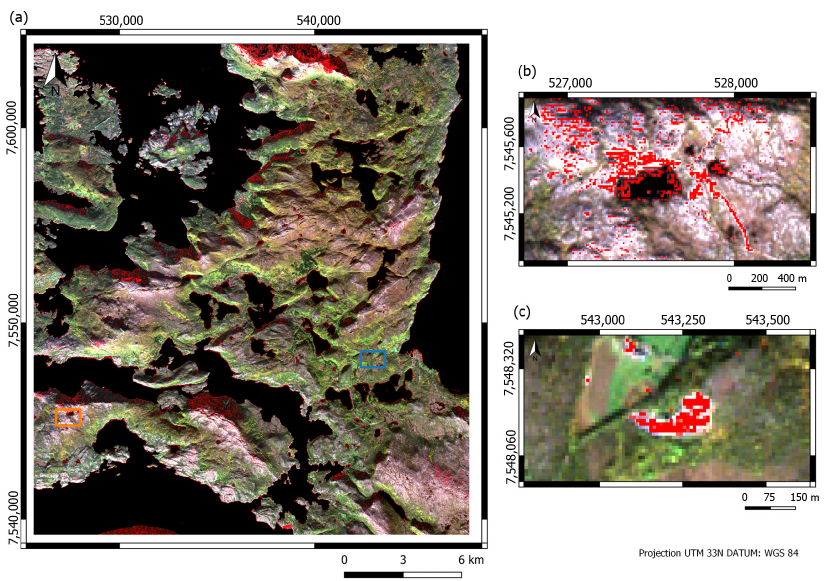
Figure 16. Result for BR 4/5. ( a ) Overview of the study area where Håkonhals mine is highlighted by the orange rectangle and Jennyhaugen mine by the blue rectangle. ( b ) Håkonhals mine in focus. Here it can be seen that this BR has also highlighted many granite pixels with elevated values. ( c ) Jennyhaugen mine in focus.